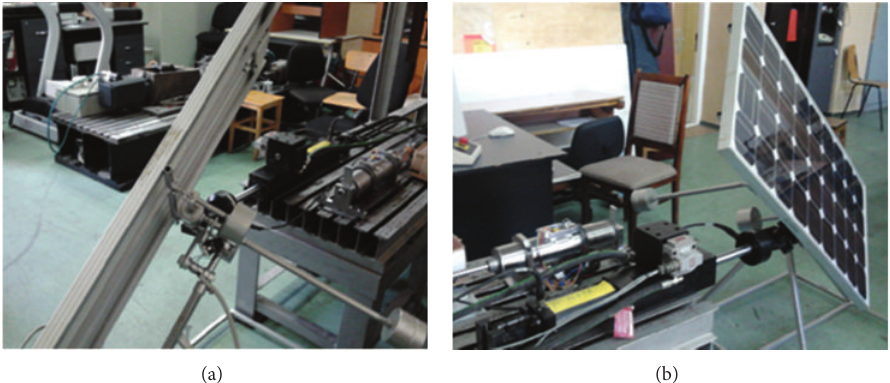
Figure 16: The experimental test for simulating the wind action.